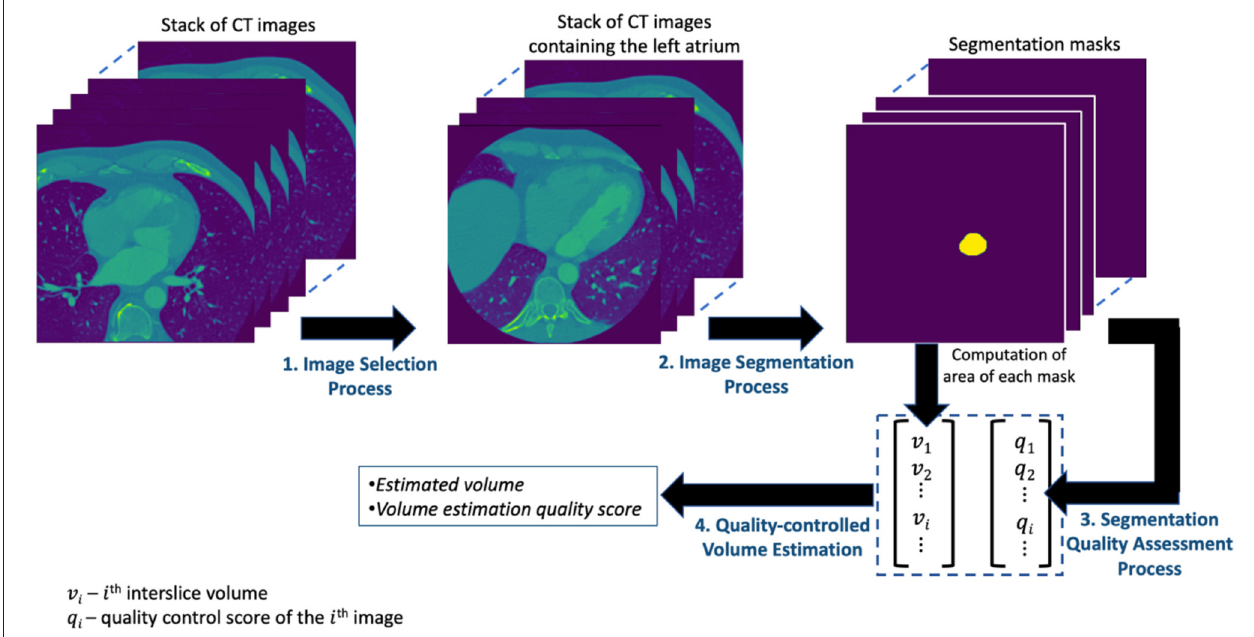
FIGURE 1 | The overview of the proposed framework for estimating the volume of LA.